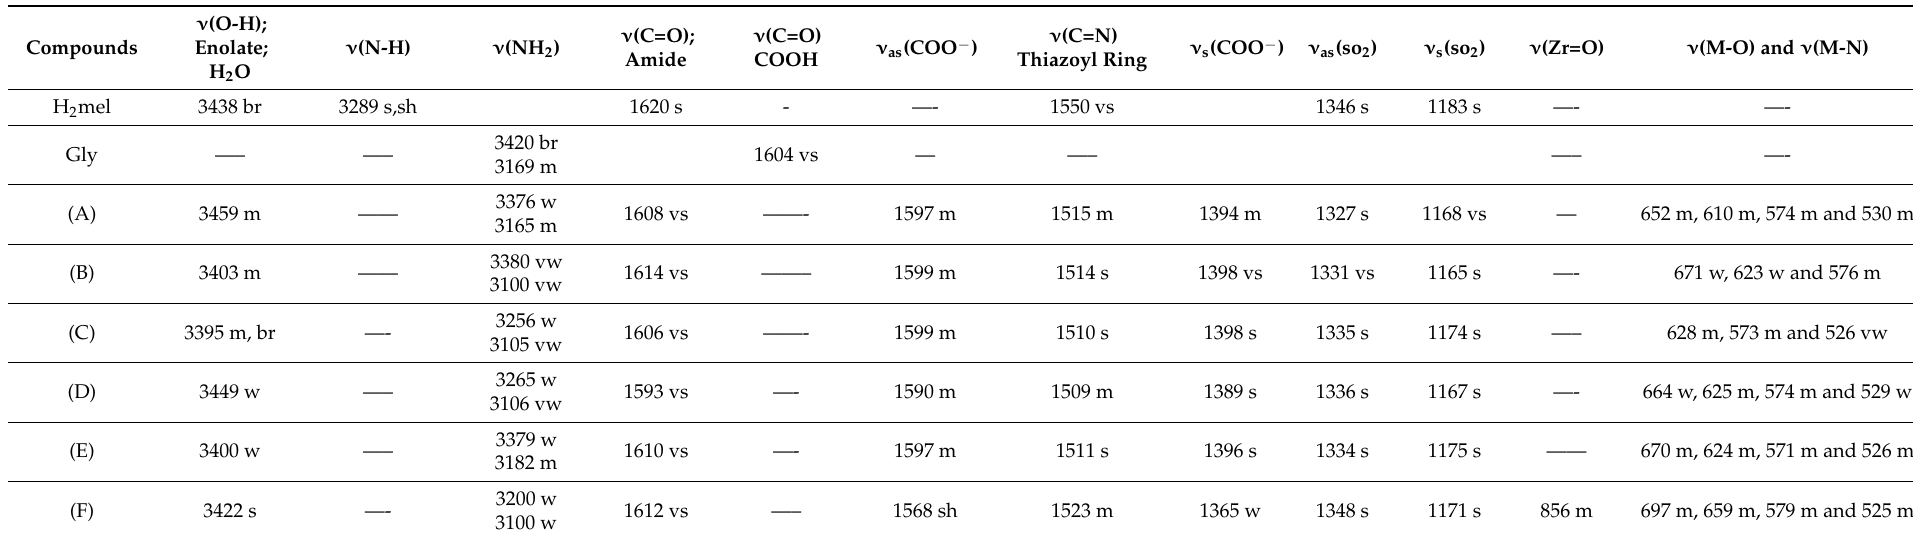
Table 1. Selected infrared absorption frequencies (cm − 1 ) for H 2 mel, Gly and their metal complexes.